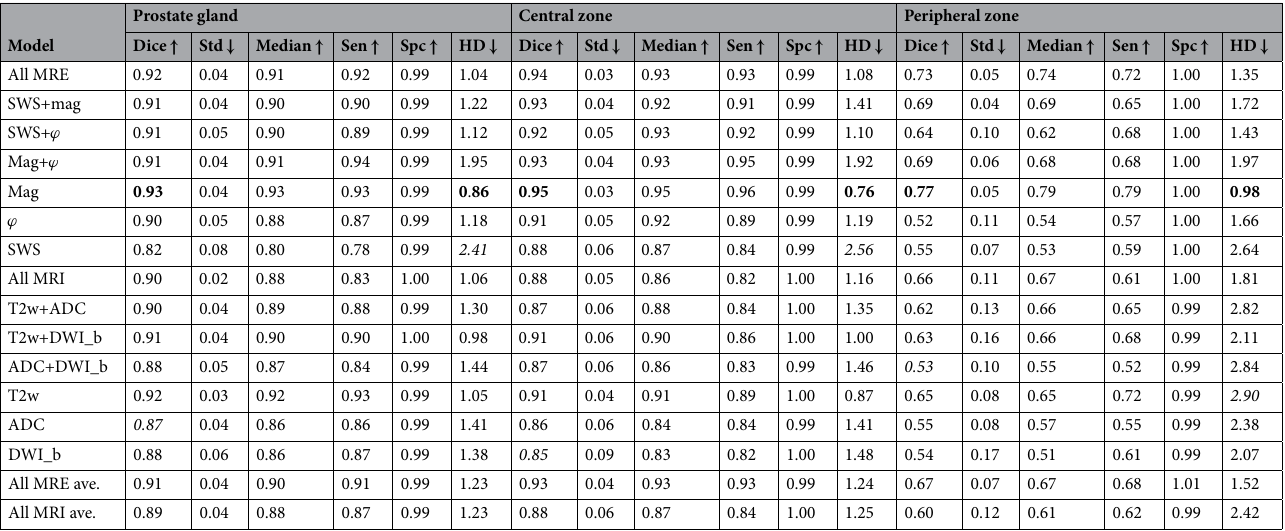
Table 2. Statistical analysis of the segmentation results of IMs. Bold indicates the highest values, while Italic indicates the lowest values. ↑ ( ↓ ): the higher (the lower) the